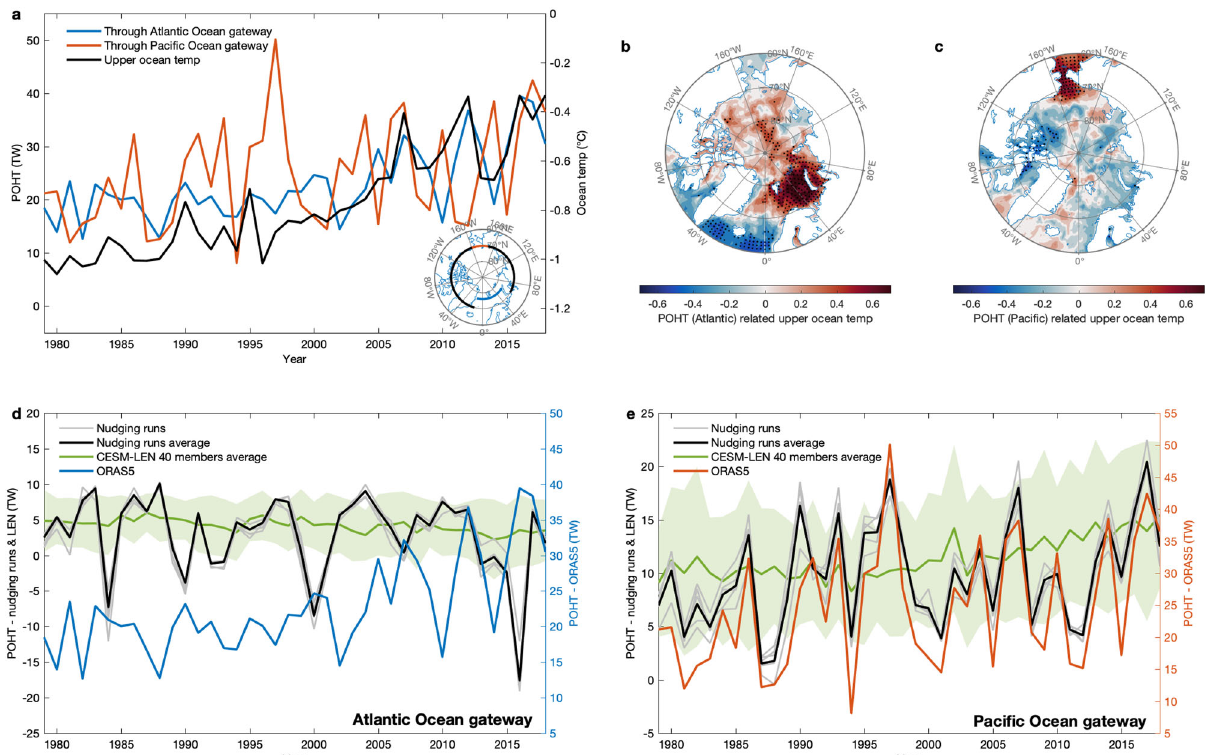
Fig. 4 Poleward ocean heat transport through the Atlantic and Paci fi c Ocean gateways in fall. a SON poleward ocean heat transport (POHT; unit: TW, 1TW = 10 12 W) within upper 50 m through the Atlantic Ocean gateway (blue line) and Paci fi c Ocean gateway (red line), and SON domain-average upper (0 – 50 m average) ocean temperature (°C, black line) using the ORAS5 reanalysis for the period 1979 – 2018. The Atlantic and Paci fi c Ocean gateways are indicated by the blue and red contours in the stereographic projection (lower right in a ). Correlations of 1979 – 2018 SON upper ocean temperature fi eld with two time series, i.e., b SON upper 50 m POHT through the Atlantic Ocean gateway in a (blue line), c SON upper 50 m POHT through the Paci fi c Ocean gateway in a (red line). SON upper 50 m POHT (TW) from 1979 to 2018 through the Atlantic Ocean gateway in d , and through the Paci fi c Ocean gateway in e from the fi ve wind-nudging experiments (gray lines, and ensemble average in black line), CESM-LEN 40 members average (green line), and the ORAS5 reanalysis (blue line for the Atlantic Ocean gateway, red line for the Paci fi c Ocean gateway). The green shading represents the one standard deviation spread of the all CESM-LEN 40 members away from the ensemble mean. All linear trends are removed in calculating the correlations in b , c . Black stippling in all plots indicates statistically signi fi cant correlations at the 95% con fi dence level. POHT through the Atlantic Ocean and Paci fi c Ocean gateways are calculated using different reference temperatures (0 °C for the Paci fi c Ocean gateway and − 1.9 °C for the Atlantic Ocean gateway,